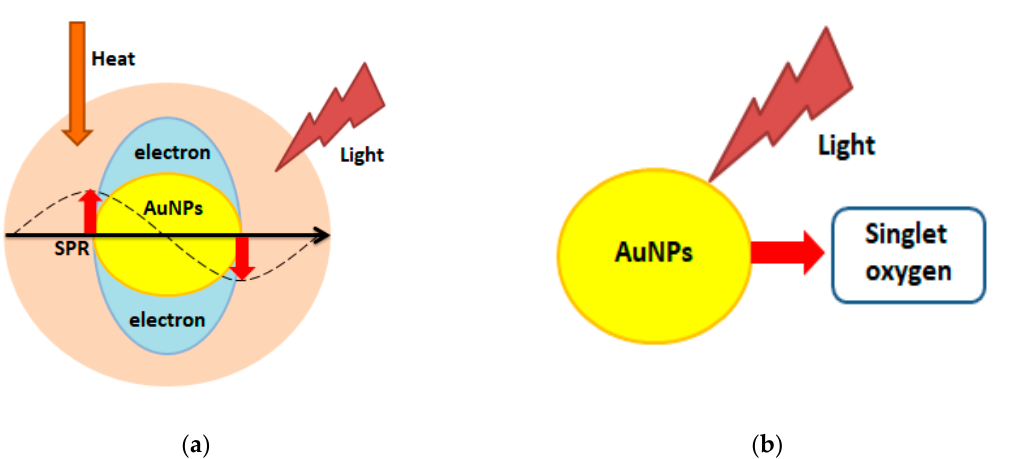
Figure 5. Schematic representation of ( a ) photothermal, and ( b ) photodynamic therapy. (modified from Reference [67]).